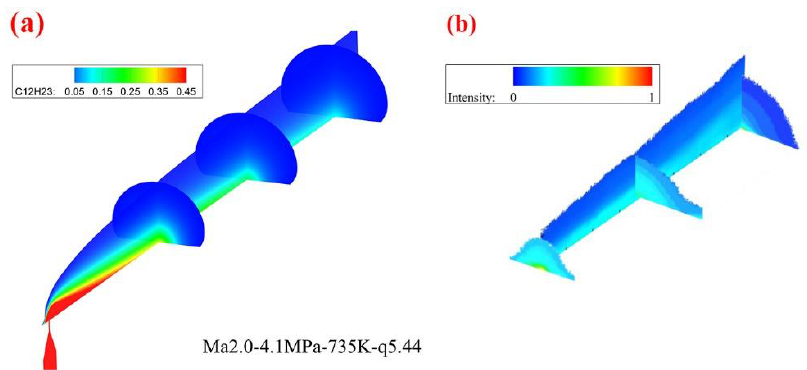
Figure 12. Comparison of EHF concentration distribution of flow field: ( a ) numerical results, ( b ) experimental results (Test 2-2).